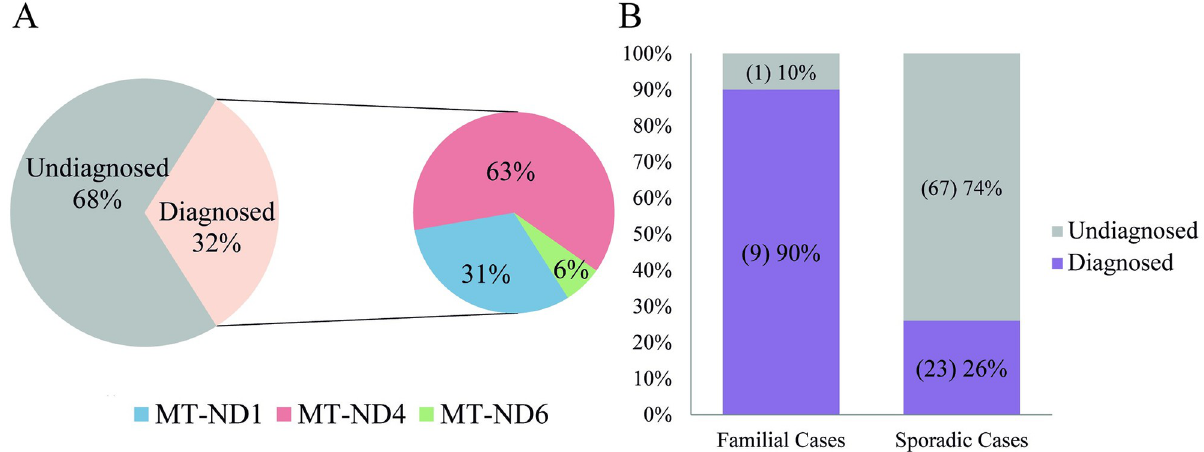
Fig 1. Identification of disease-causing variants. A, General diagnostic rate and frequency of genes harboring pathogenic variants in diagnosed patients. B, Diagnostic rate in family and sporadic cases.